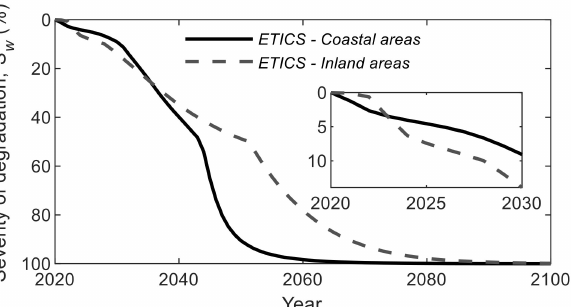
Figure 12. Comparison of the ETICS degradation curves without maintenance for the coastal and inland areas.